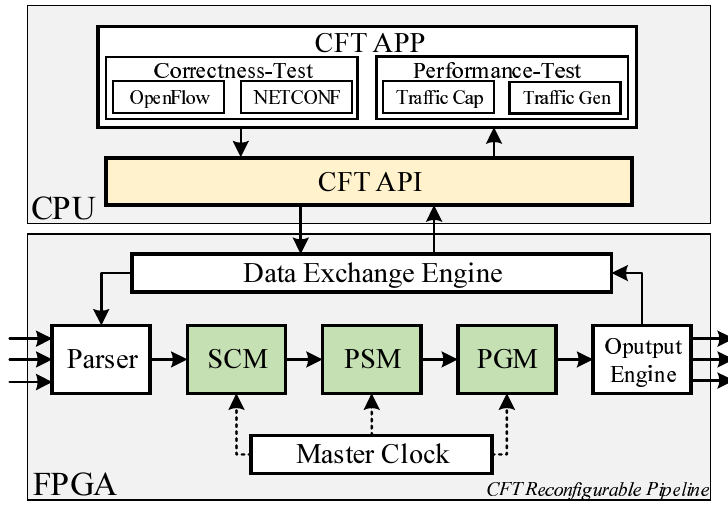
Figure 1. The architecture of the co-design tester